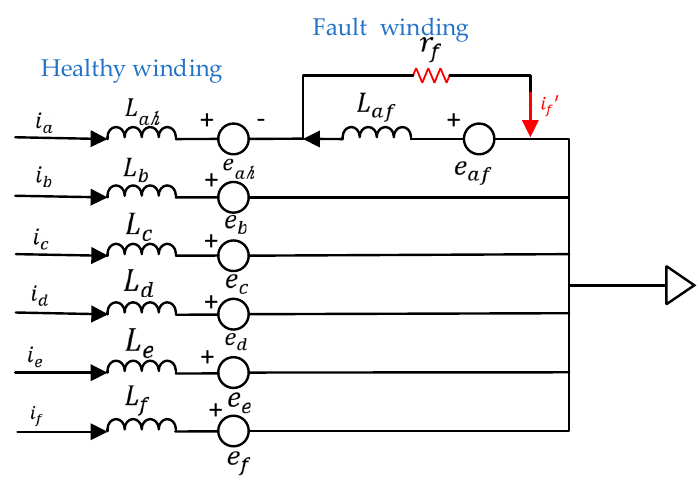
Energies 2017 , 10 , x FOR PEER REVIEW